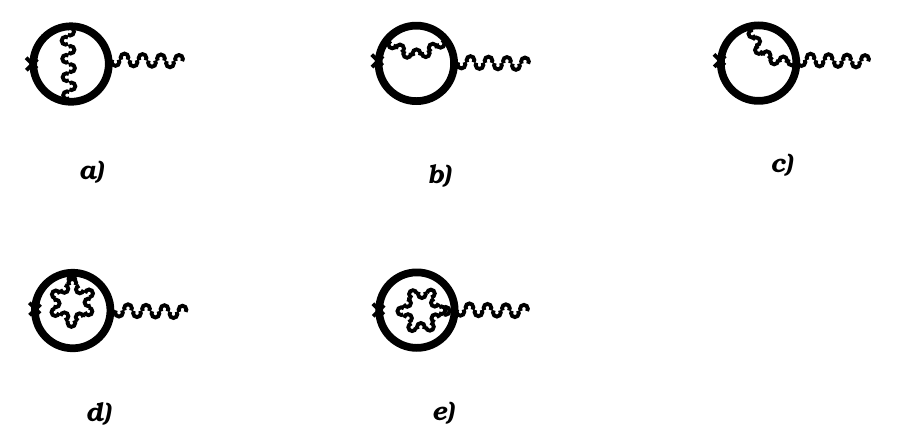
Figure 3 . Diagrams associated with the next order correction to the mean (cid:12)eld for T zz . The combinatorial factors are a ) + 2 b ) (cid:0) 2 c ) (cid:0) d ) + 1